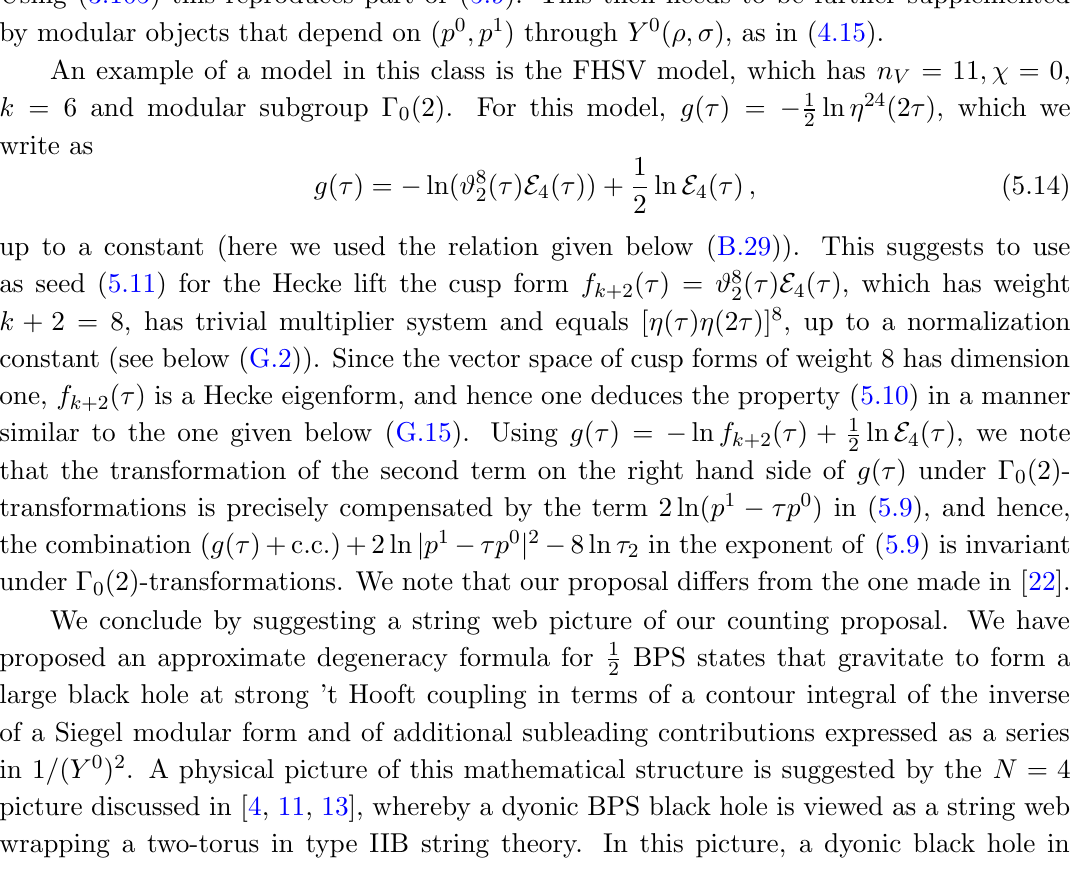
Figure 1. String web